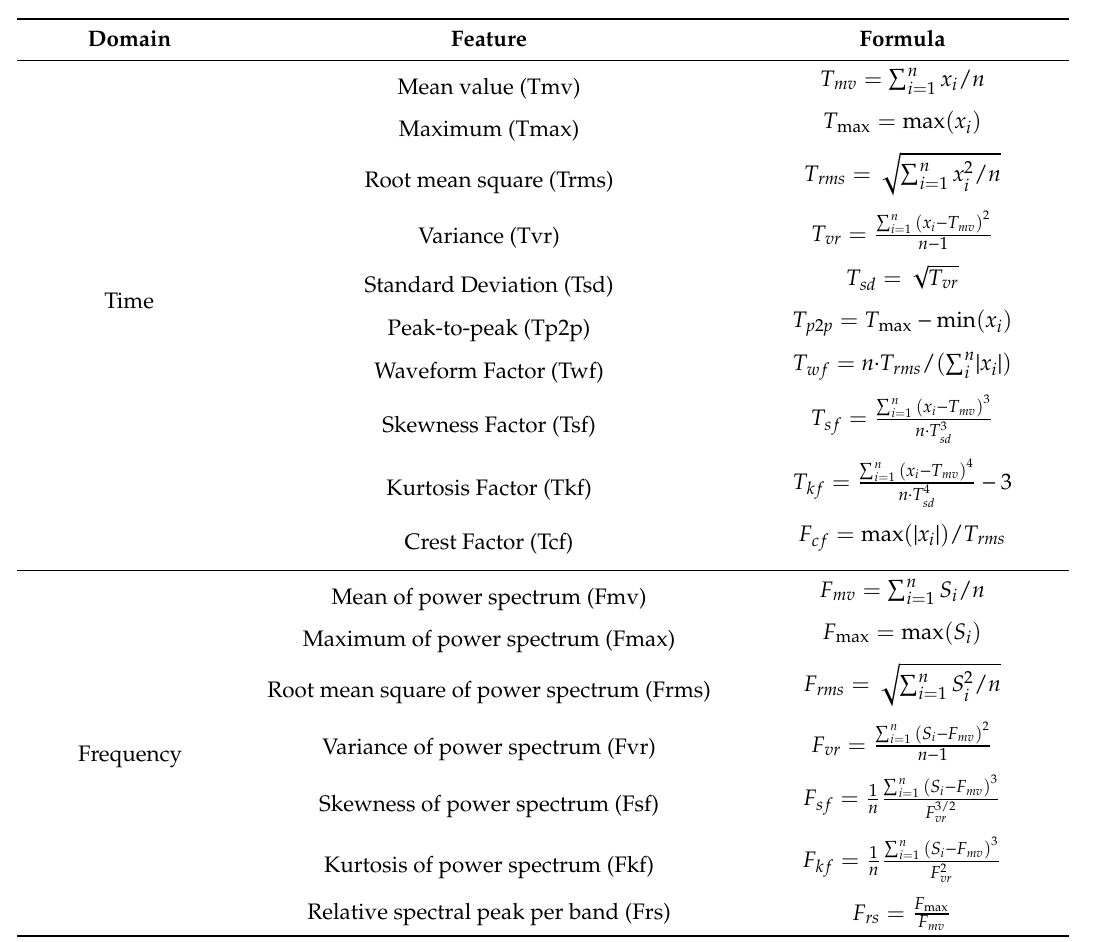
Table 1. Features extracted in time domain and frequency